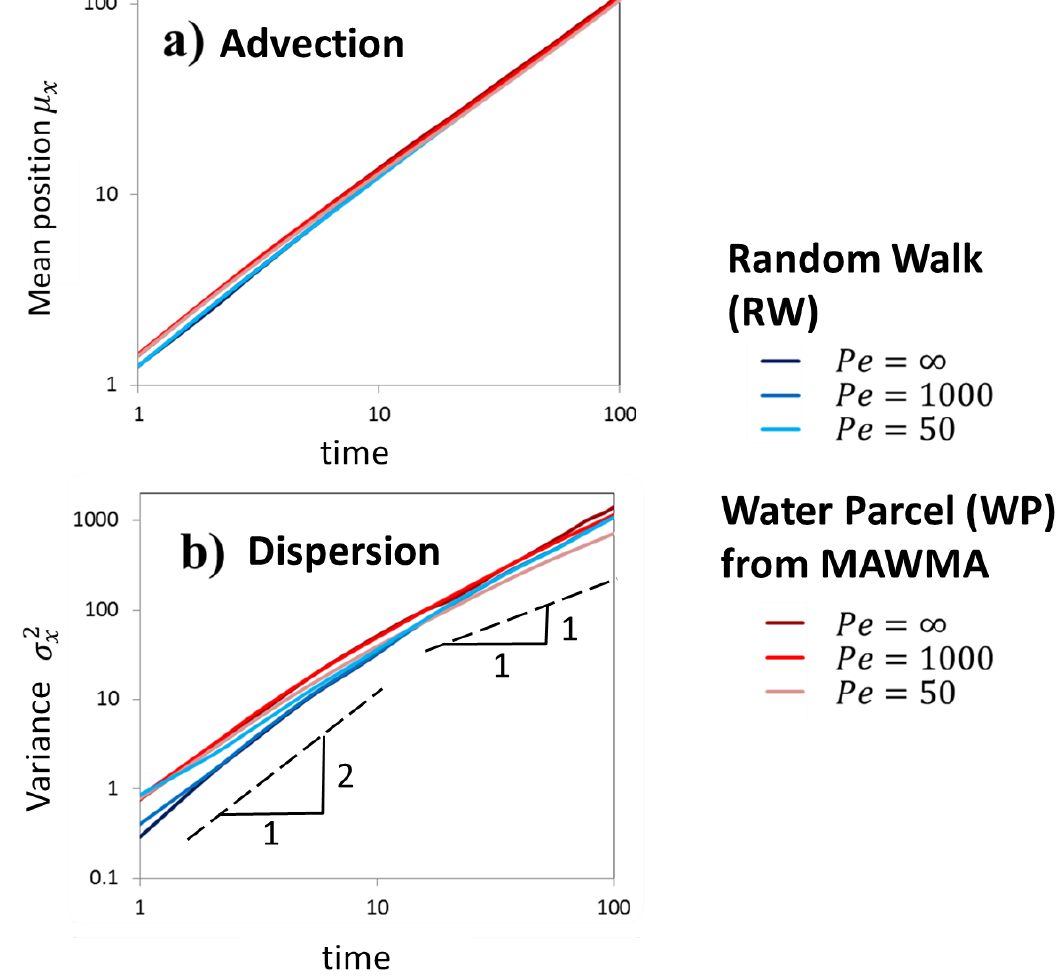
Figure 5. Temporal evolution comparison of ( a ) mean x position and ( b ) solute concentration variance in x between random = 1 heterogeneity walk and water parcel methods at σ 2 Y